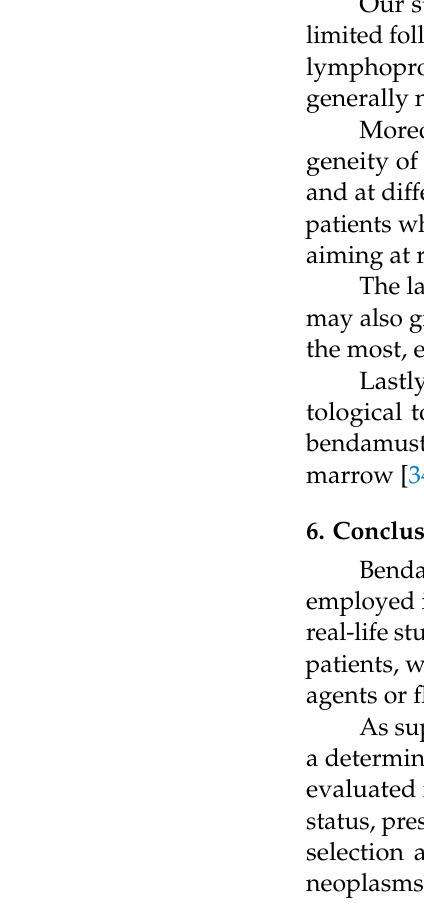
TTP, Table S1: Characteristics of the patients stratified according to pathological diagnosis, Table S2: Bendamustine treatment characteristics stratified by